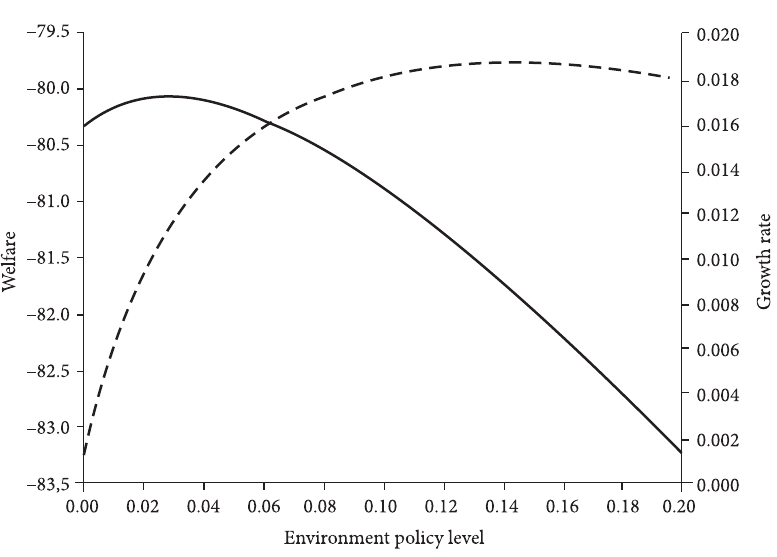
Fig. 3. Impacts of the environment policy on growth and